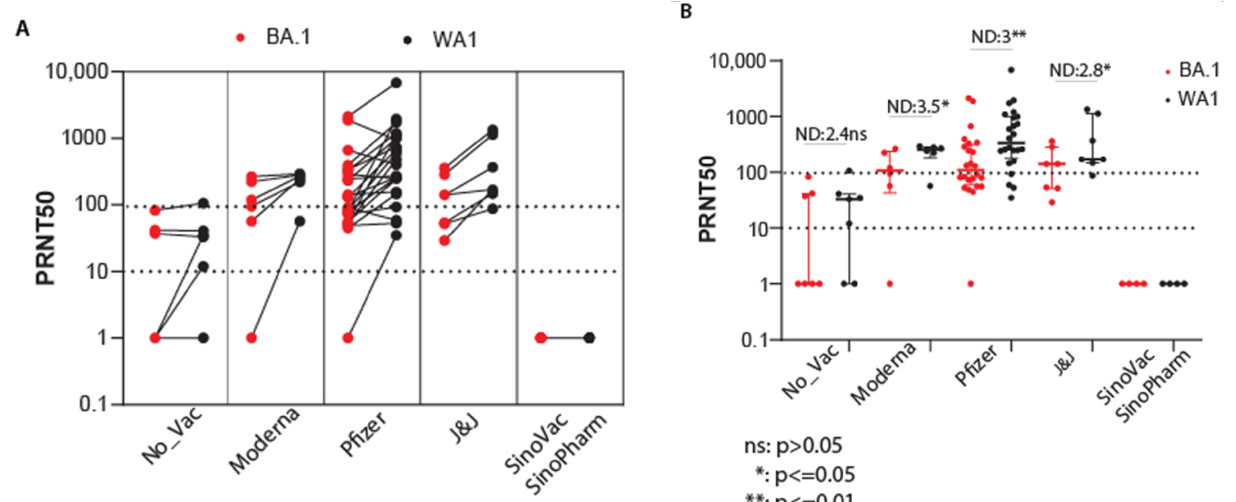
Figure 3. Convalescent sera do not protect against Omicron but vaccination following infection and recovery enhances humoral immunity for virus neutralization. Serum samples were provided from a longitudinal cohort of SARS-CoV-2 infection. Convalescent individuals either received no vaccine or were vaccinated with the indicated vaccines (Table 2). Sera were evaluated for virus neutralization by PRNT50 assay against SARS-CoV-2/WA-1 and the Seattle Omicron BA.1 variant in side-by-side paired testing. ( A ). Geometric mean and standard deviation PRNT50 titers of individual sera in paired testing against each virus. ( B ). PRNT50 of serum analyses showing geometric mean and standard deviation, with all input data points. Neutralization difference (ND) values were calculated by dividing the mean PRNT50 value of SARS-CoV-2/WA-1 neutralization by the PRNT50 mean of Omicron BA.1 neutralization for each sera set. PRNT50 values were statistically evaluated using paired t -test. p -values are shown for each comparison. The PRNT50 10 lower limit neutralization value and 100 value are marked by the dotted